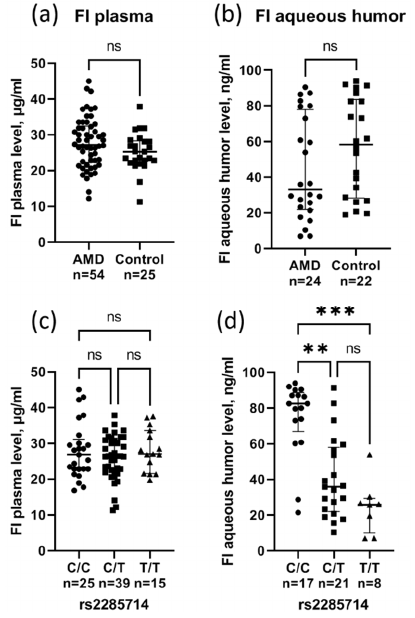
Figure 1. The complement factor I plasma ( a ) and aqueous humor ( b ) level in patients with AMD and controls (circles for AMD group, squares for control group). Effect of rs2285714 genotypes on FI levels in plasma ( c ) and aqueous humor ( d ) (circles for C/C group, squares for C/T group, triangles for T/T group). Median (q1–q3), ns: not significant, ** p < 0.01, *** p < 0.001 Kruskal–Wallis test with Dunn’s multiple comparisons